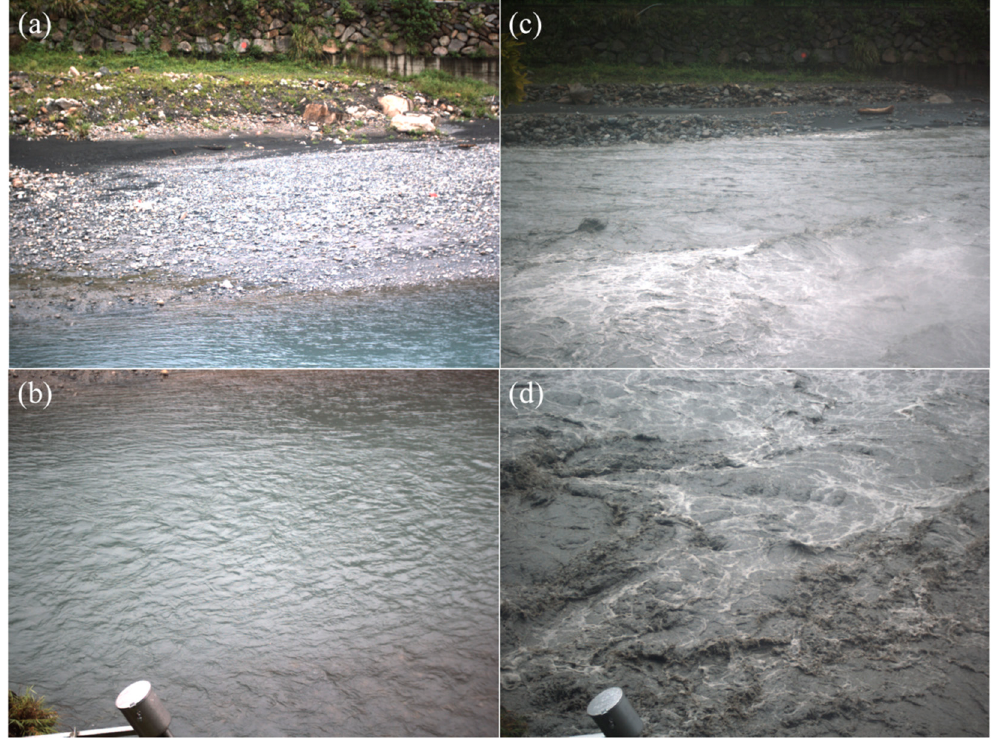
Figure 2. The far- and near-field photos obtained from the dual cameras: ( a , b ) for the normal flow condition; ( c , d ) for Typhoon Soudelor in August 2015.